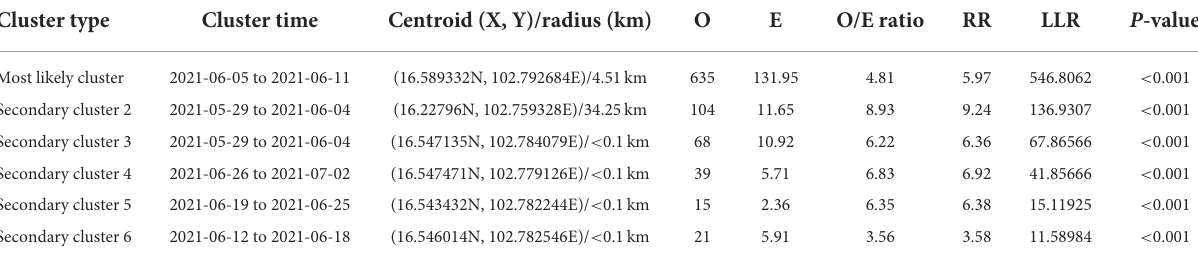
TABLE 2 Spatio-temporal analysis of lumpy skin disease outbreaks in dairy farms, Khon Kean province, Thailand by Poisson model.